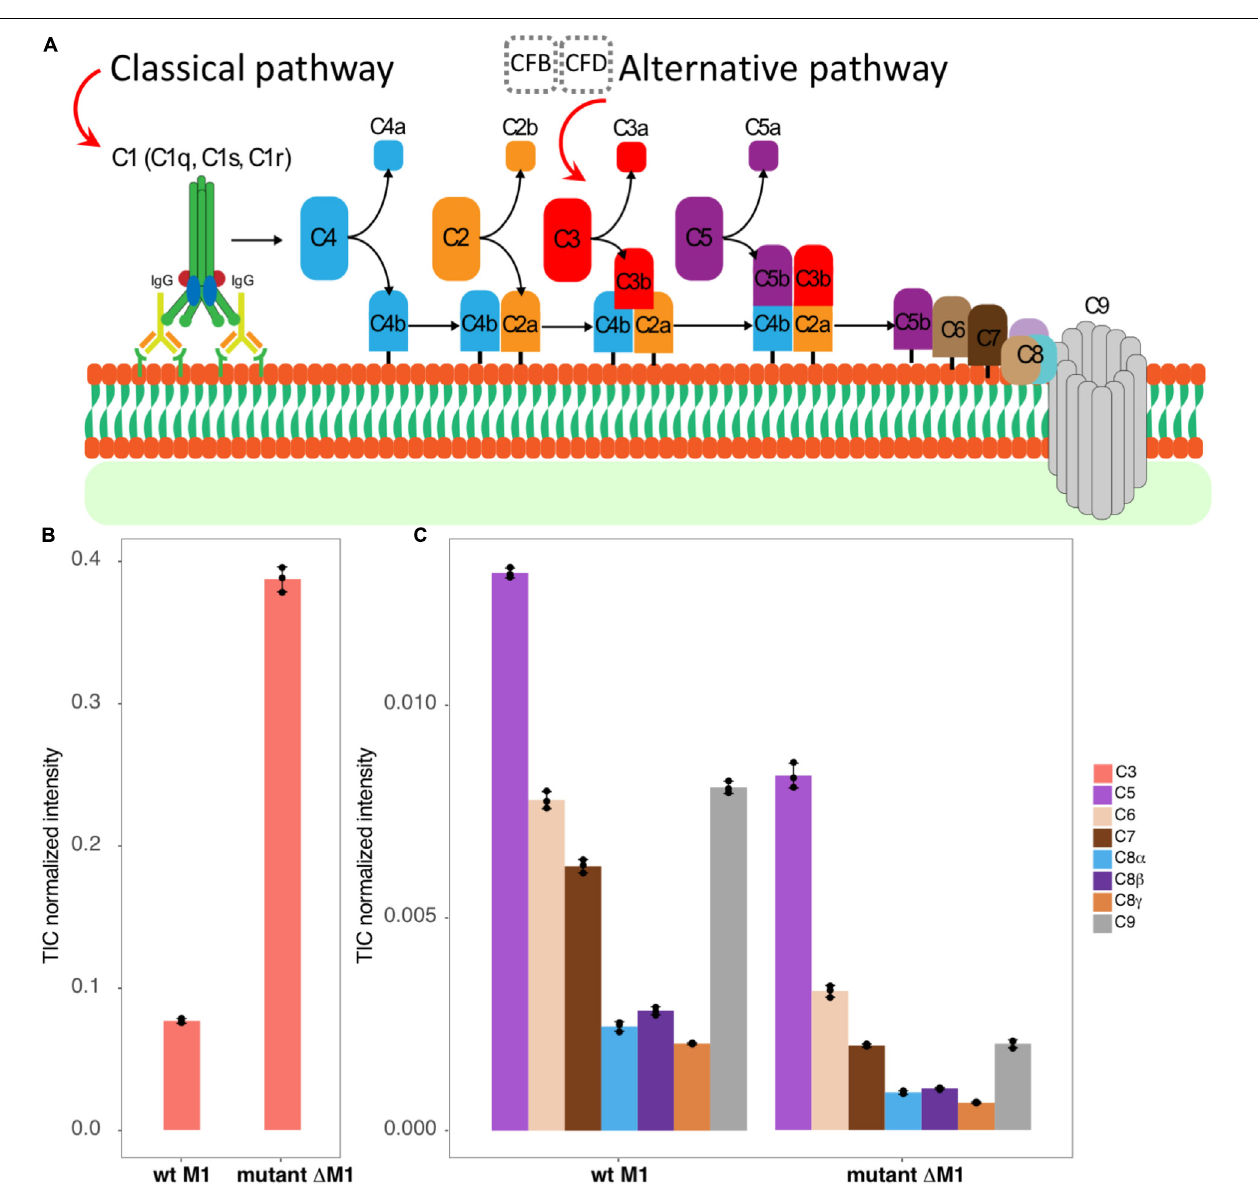
FIGURE 1 | The studied system. (A) A schematic view represents briefly how classical and alternative complement pathways activated by antigen–antibody interaction, or by factors B and D, lead to C3 convertase production that eventually brings the MAC C5b–C9 components to assemble as a pore on the surface of the bacteria. (B,C) The bar graphs represent TIC-normalized intensity of complement proteins in human plasma adsorption samples. It provides a comparison between the wt strain SF370 (left) and the mutant strain (cid:49) M1 (right) for C3 (B) , C5, C6, C7, C8, and C9 components (C)